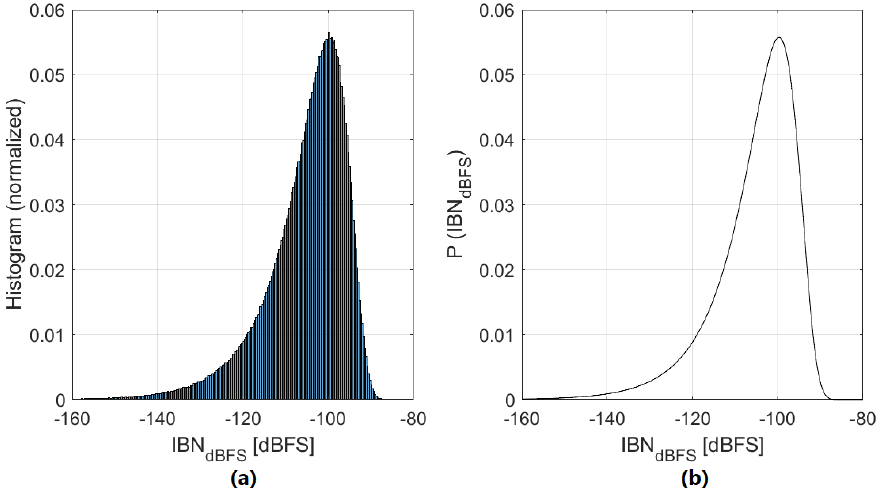
Figure 12. Comparison of (21) with 100,000 simulations of noise power in NP regions. Σ∆ M parameters are: third-order, 4-bits, OSR = 38, OBG = 1.8, and σ T = 0.1%. ( a ) Normalized histogram. ( b ) Equation (21).